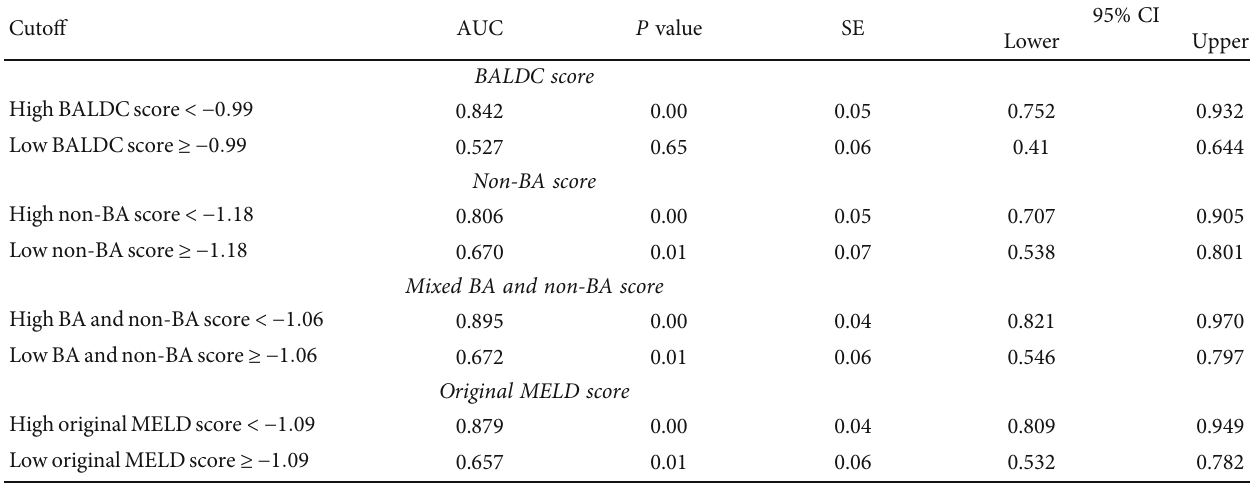
Table 8: ROC analysis using optimum cut-o ff